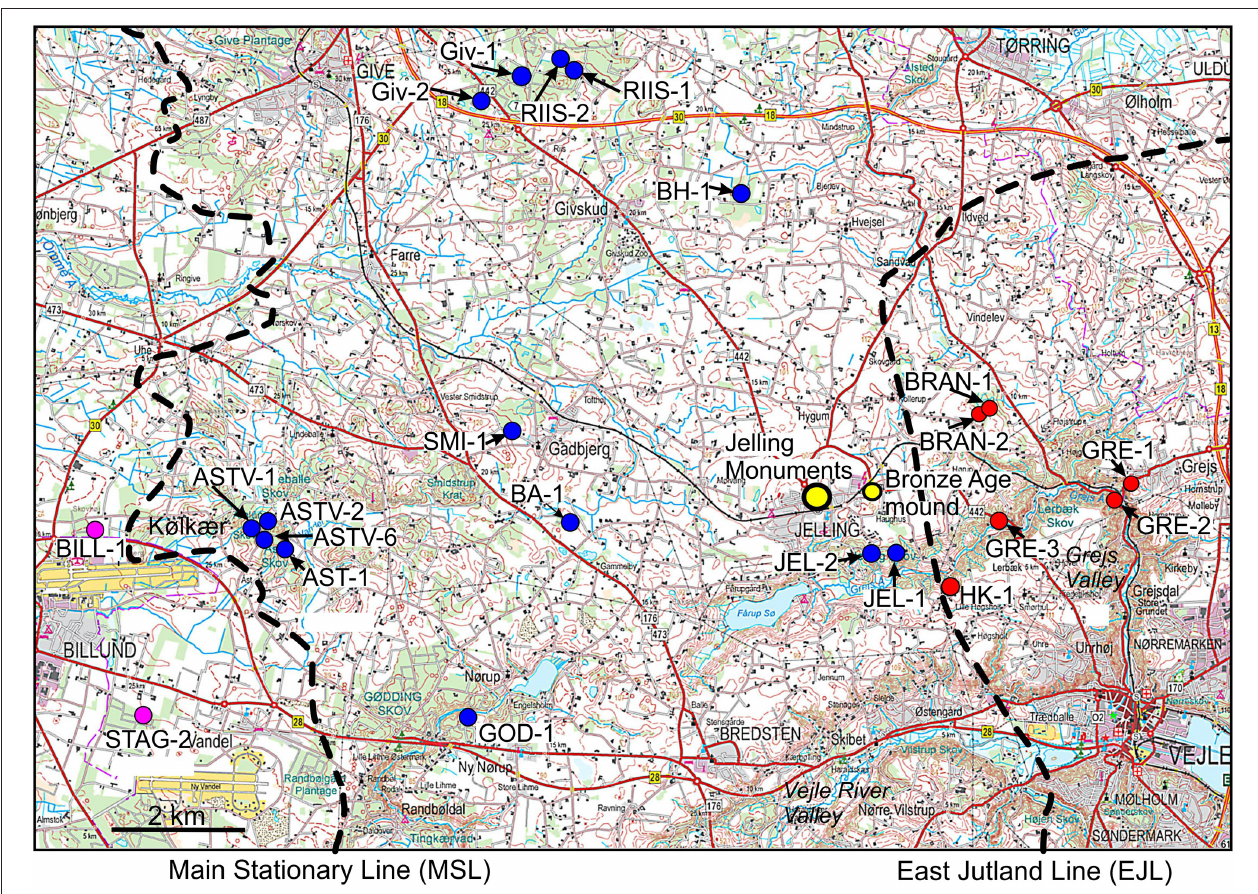
FIGURE 6 | Modern topographical map of study area S3, Jelling. Sample location and sample number are indicated. Detailed information on location of samples and laboratory data are given in Table 1 . For location of study area see Figure 1A . Location of the Jelling Viking Monuments and a recently analyzed Bronze Age burial (Felding et al., 2020) are indicated. Map is based on free data from “Styrelsen for Dataforsyning og Effektivisering, topografisk kort,